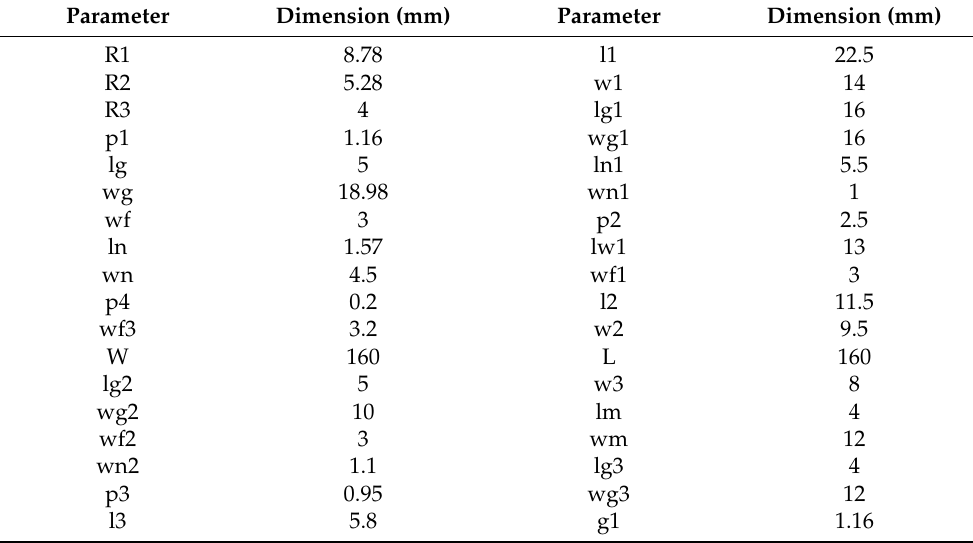
Table 2. Dimensions of the 25-port CR MIMO